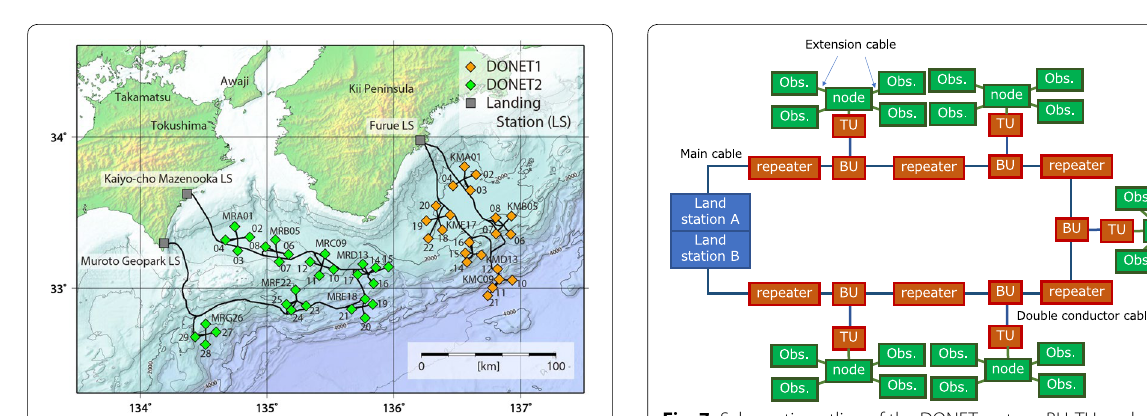
Fig. 6 Distribution of DONET observatories with landing stations. The contours indicate bathymetry